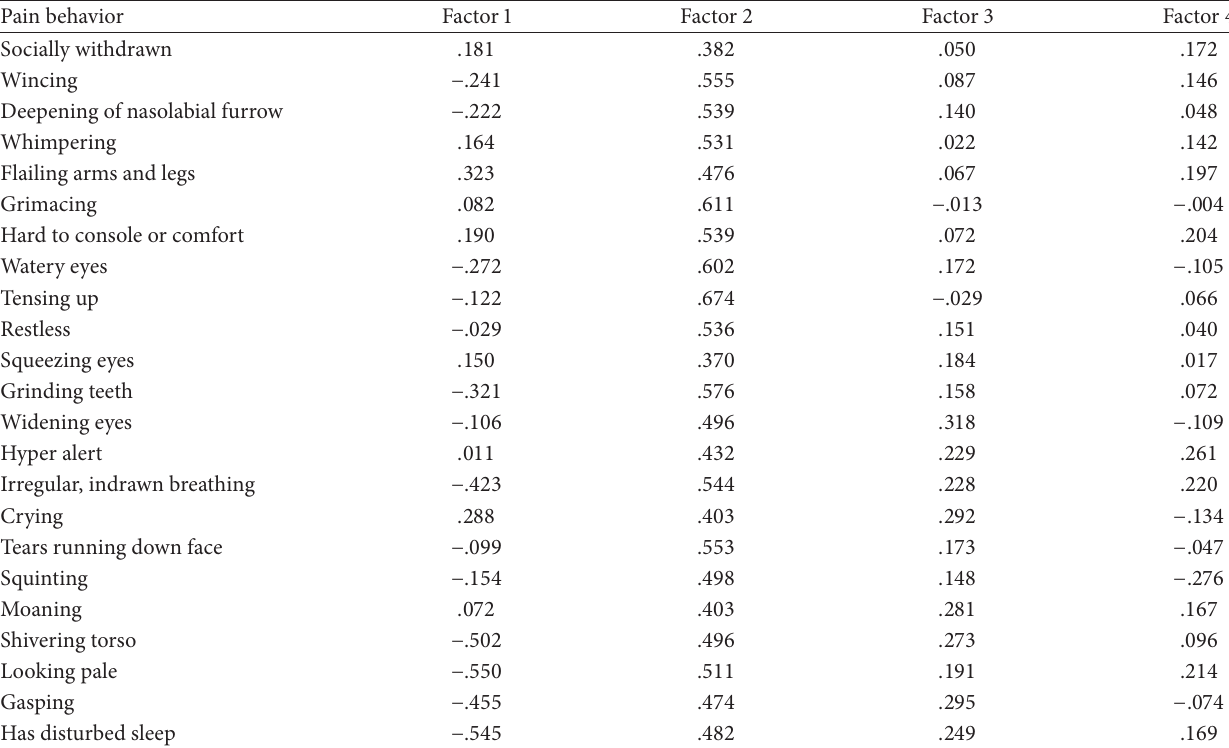
Table 2: Final list of pain behaviors extracted from pediatric observational pain scales that loaded on factor 2, which we labeled as the “Automatic”